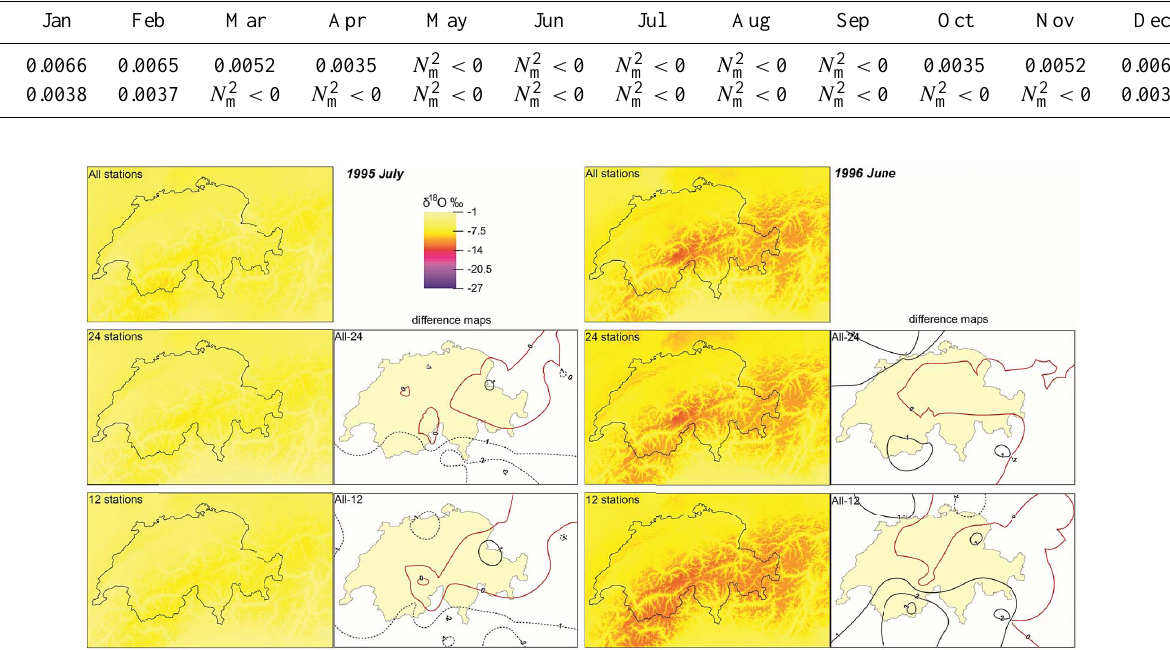
Fig. 3. Precipitation oxygen isoscapes for Switzerland derived for July 1995 and June 1996. Top map shows the isoscape obtained using all available stations. The longest-running 24 and 12 station records have been used for the middle and bottom maps, respectively. The difference map, obtained after grid computed with reduced data set was subtracted from the full one, is shown to the right of the corresponding subset- derived map. Isolines for positive values are shown by the bold lines, while negative values are shown by the dashed lines. The zero isoline is